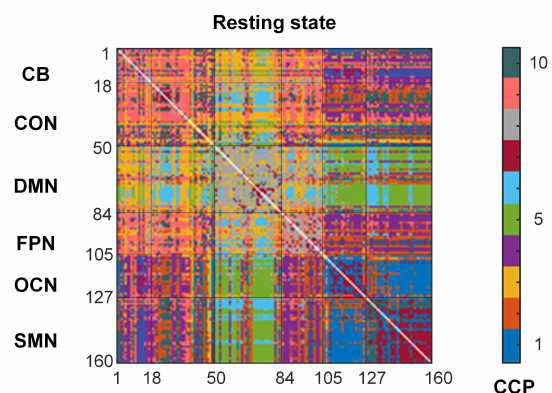
Figure A6. The CCPs in the linearly embedded Euclidean space obtained with a K-means clustering